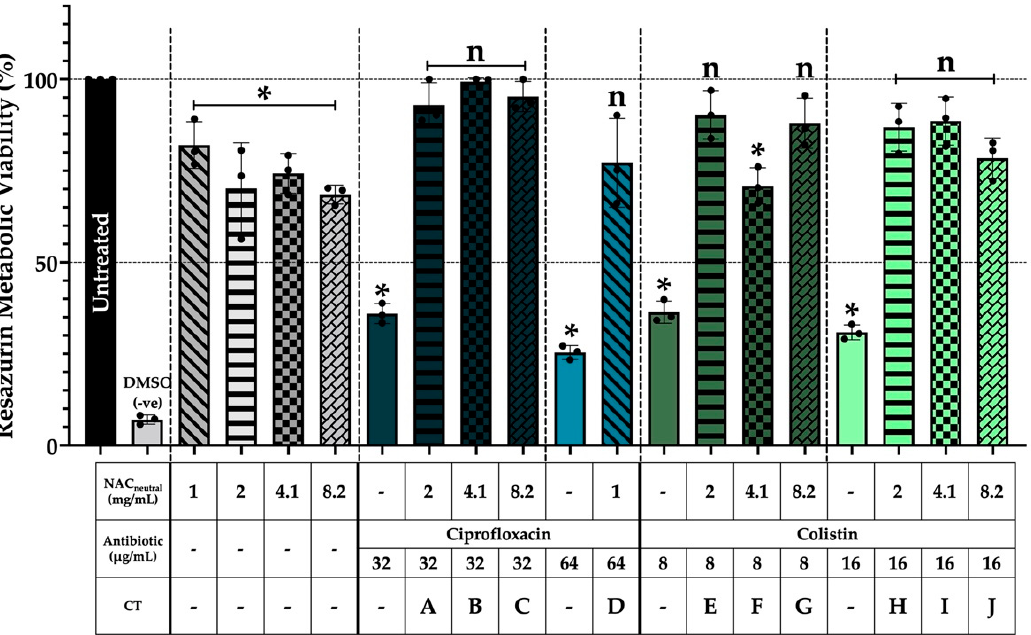
Figure 3. THP-1 cells maintained metabolic viability after three-hour combination therapy treatment challenge. THP-1 cells were grown in suspension until a density of 2–4 × 10 5 cells/mL was achieved. Cells were differentiated by seeding into 24-well plates at a density of 2 × 10 5 cells/mL in a final concentration of 160 nM PMA for 48 h. Cells were washed and combinations were added to a concentration of 20% ASMDM-1 and 80% RPMI medium for three hours and metabolic viability was measured using resazurin staining. (*) indicates the results are statistically significant ( p ≤ 0.05) based on unpaired Student’s t -tests (with Welch’s correction). Experiments were performed in biological triplicate (n = 3).